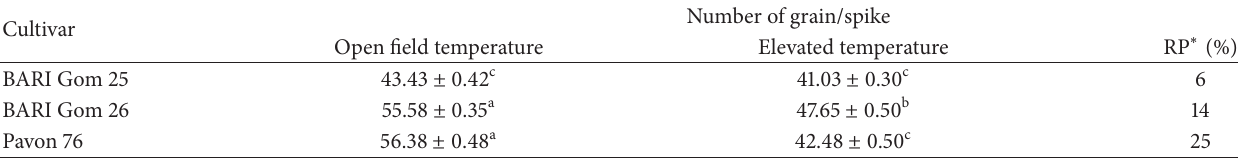
∗ RP = reduction percentage relative to open field temperature condition. The values have been given as arithmetic mean ± SE. Values in a column with different letters are significantly different at 𝑃 ≤ 0.05 by DMRT. Table 2: Grain weight per main stem in three wheat cultivars under open field and elevated temperature conditions. Cultivar